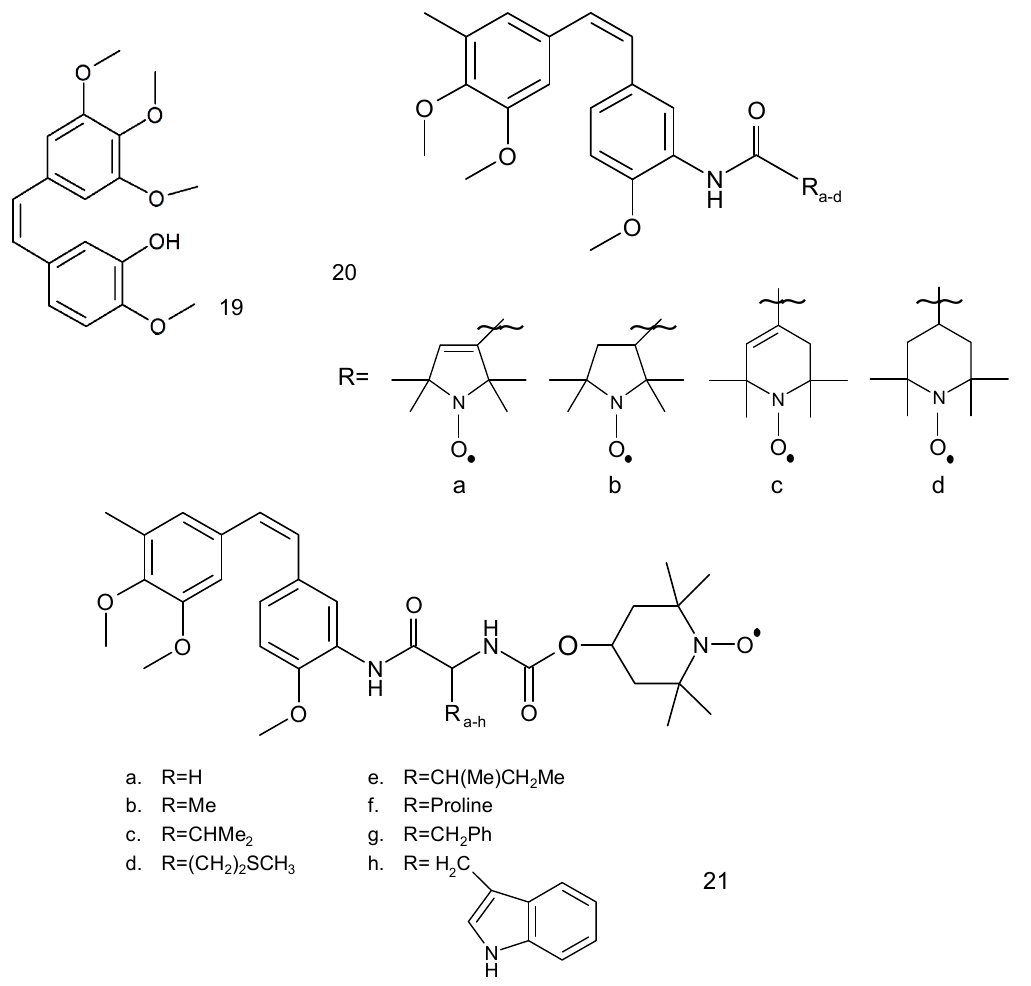
Figure 6. Natural and synthetic anticancer compounds: ( 19 ) combretastatin, ( 20 ) combretastatin with different spin label residues and ( 21 ) spin-labelled combretastatin derivatives.